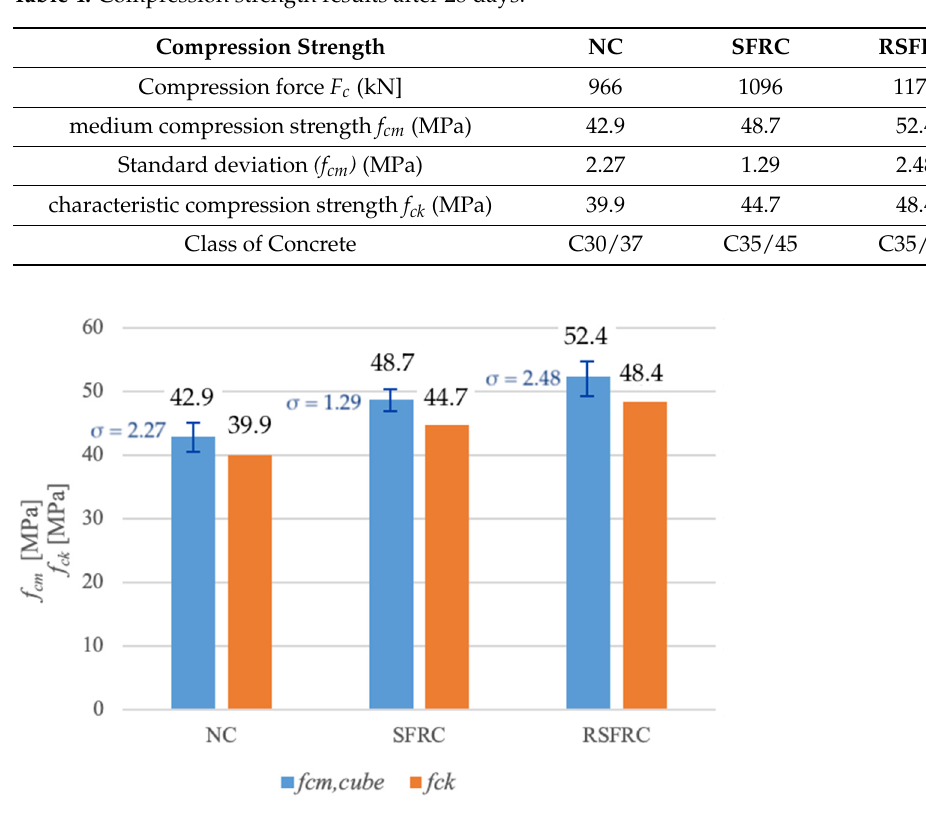
Figure 15. Comparison of medium ( f cm ) and characteristic ( f ck ) compression strength of tested concretes without fibres (NC) and with steel fibres (SFRC and RSFRC).